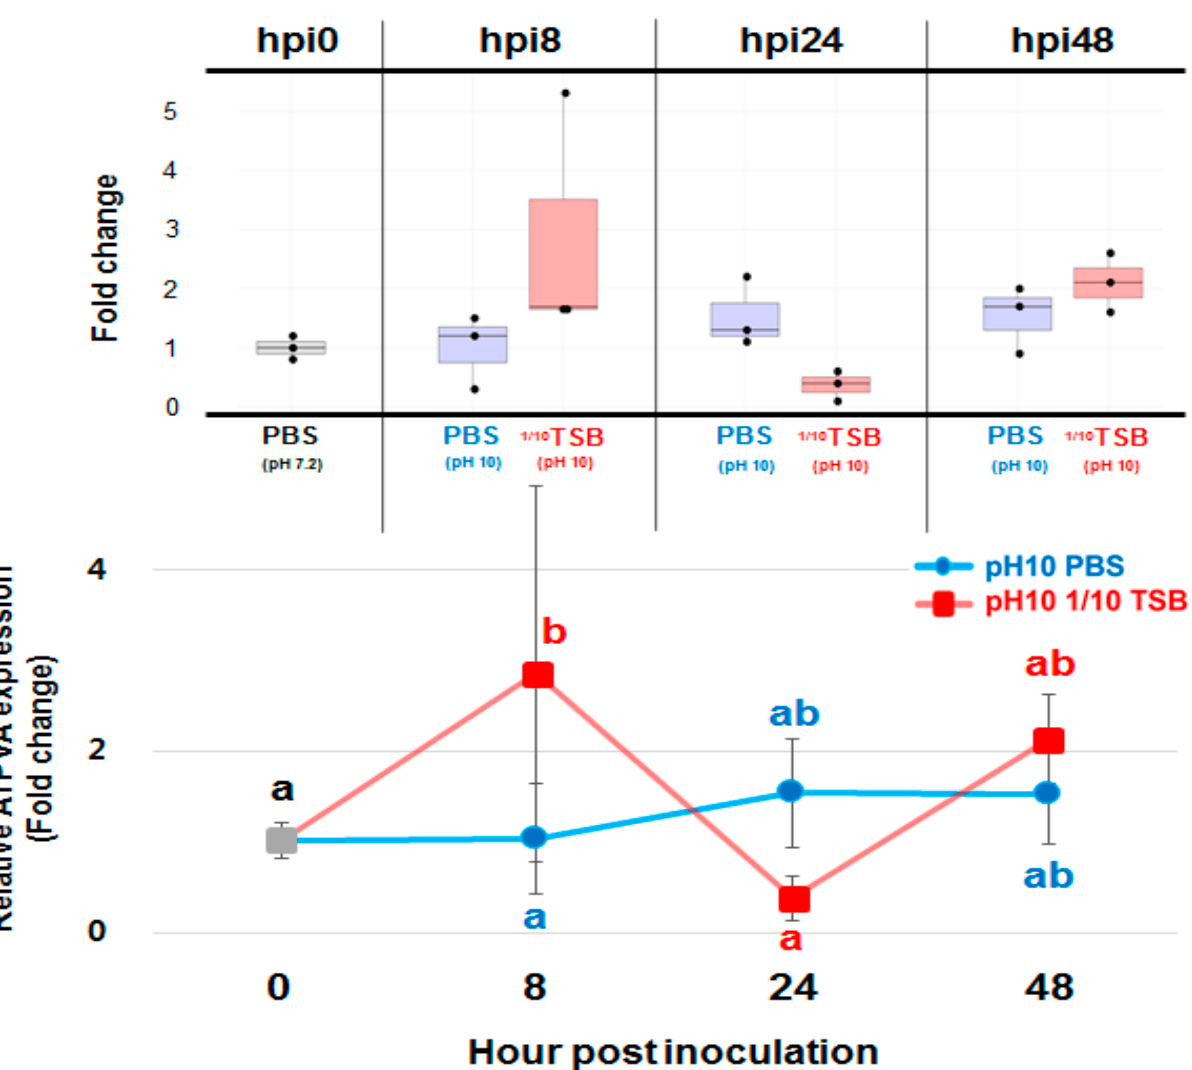
Figure 4. Relative V-type ATPase Subunit A (ATPVA) gene expression in DSM20342 strain under PBS and 1/10 TSB at pH 10. The dots in the box plot indicate the fold change of each sample compared to hpi0. Different letters indicate statistically significant differences determined via Duncan’s multiple range test among all groups ( p < 0.05).